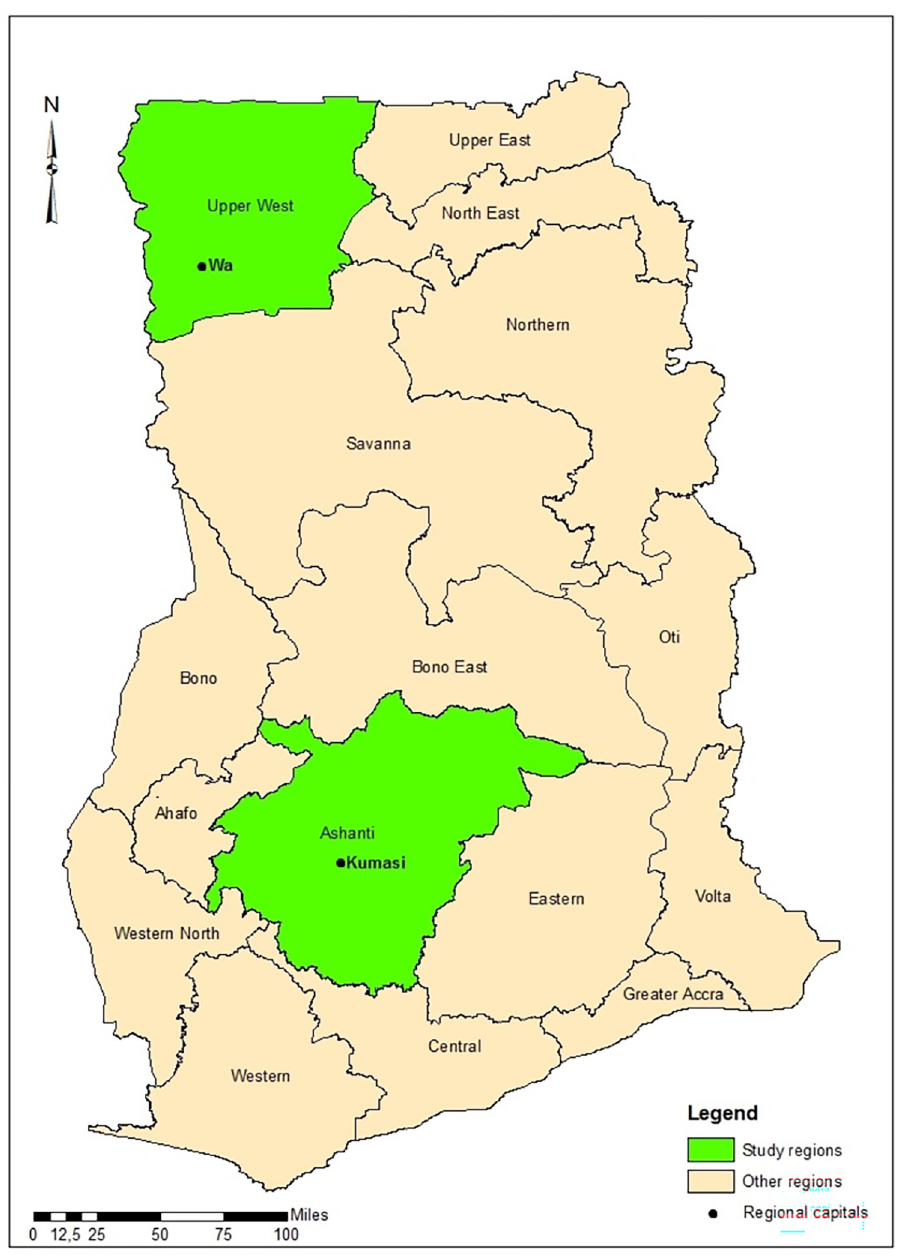
Fig 1. A map of Ghana showing the study regions (ArcGIS software version 10.8.1, ESRI Inc., Redlands, CA, U.S. A).